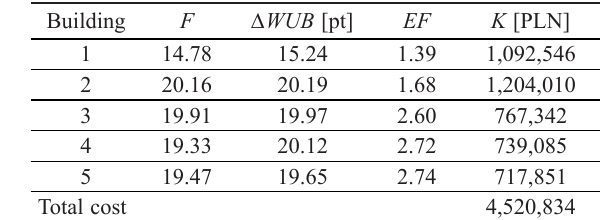
table 7. Comparison of repair variants (solution 1) building